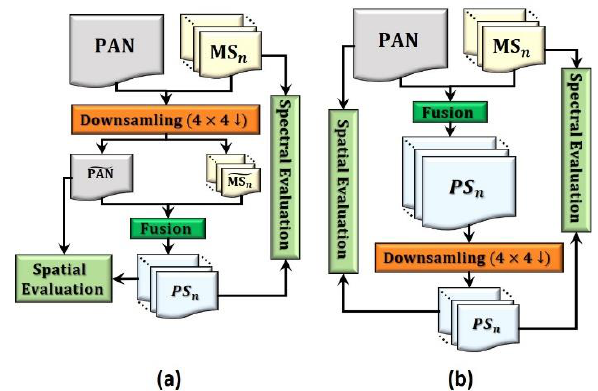
Figure 2. Wald’s protocol: (a) the first (standard) algorithm, (b) the second